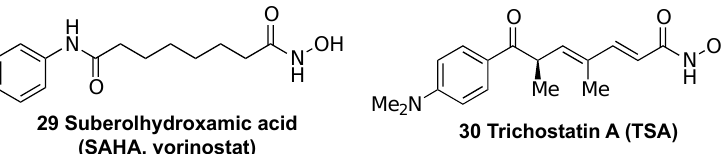
Figure 13. Chemical structures of histone deacetylases (HDAC) inhibitors suberolhydroxamic acid (SAHA) ( 29 ) and trichostatin A (TSA) ( 30 ).